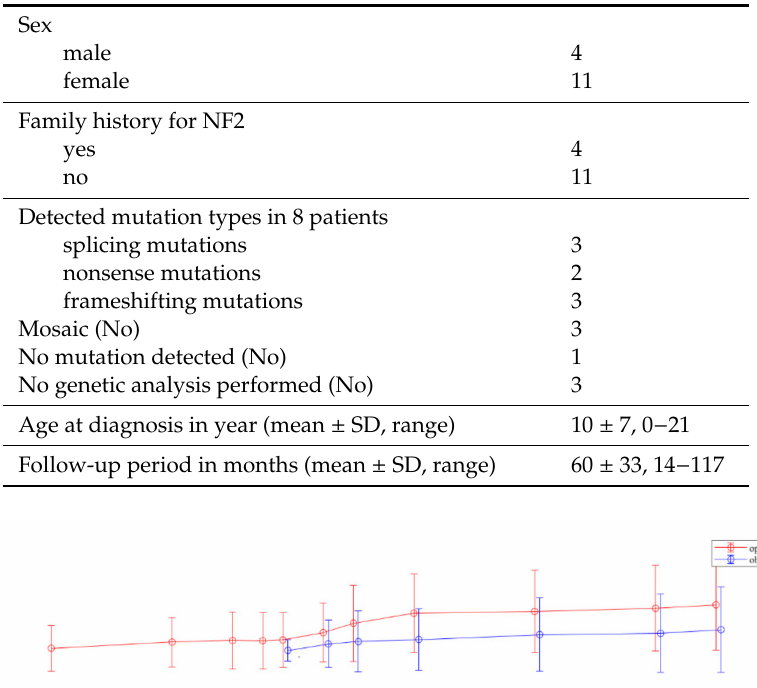
Table 4. Demographic data of 15 young non-operated NF2 patients (20 tumors).